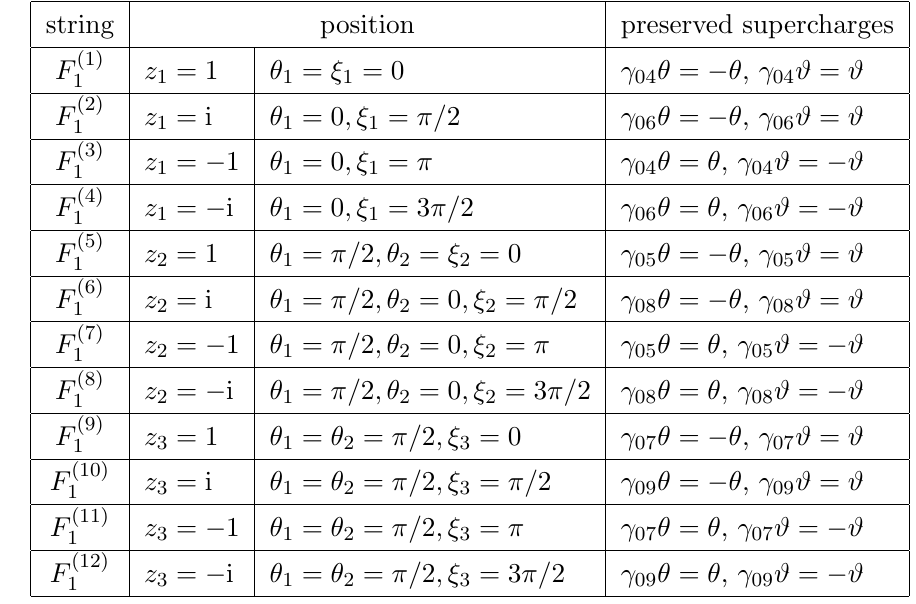
Table 1. The twelve di(cid:11)erent fundamental strings at di(cid:11)erent positions and their preserved su- percharges. A similar table can be constructed for anti-string (cid:22) F ( i )